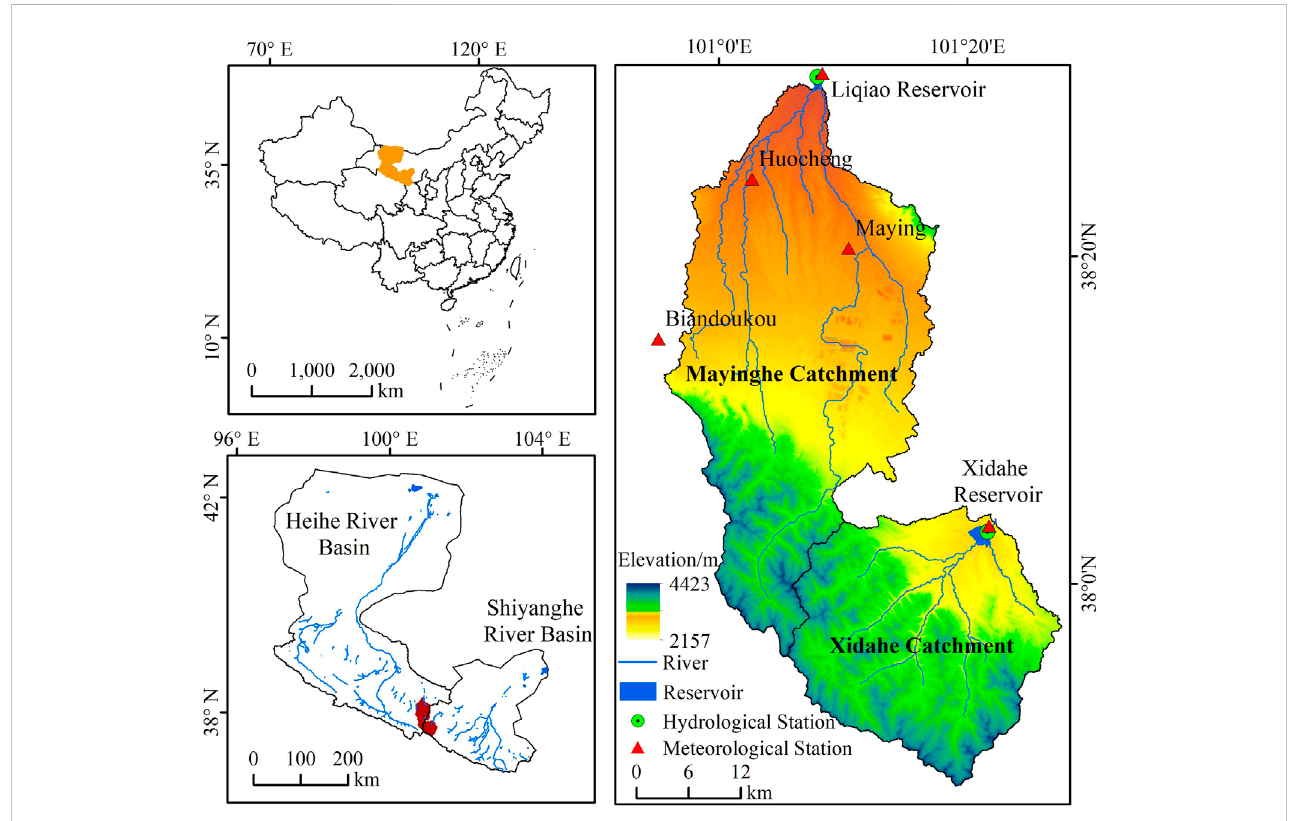
FIGURE 1 Geographical location, river and topographic characteristics and locations of meteorological and hydrological stations of XDC (Xidahe Catchment) and MYC (Mayinghe Catchment).